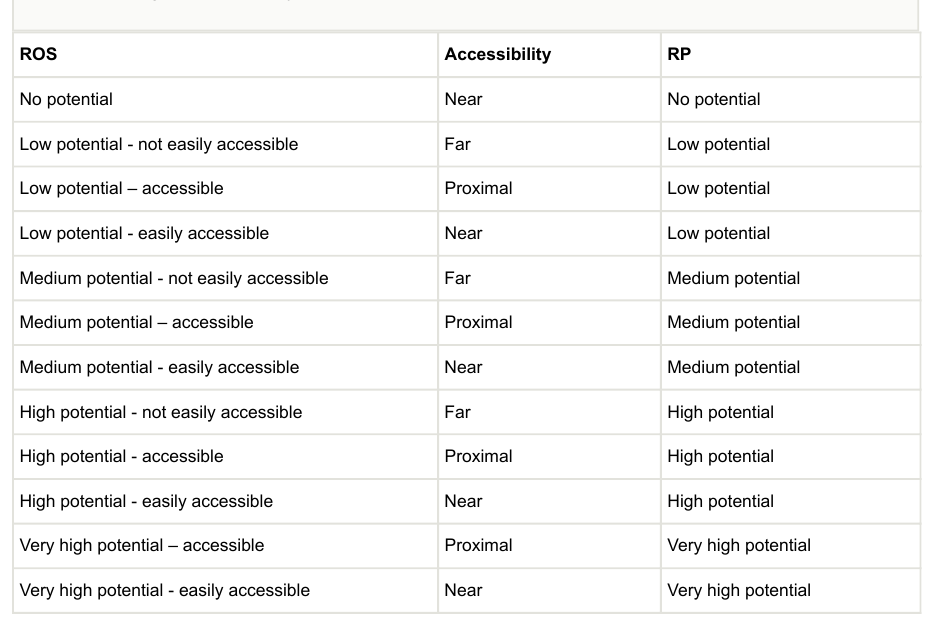
Table 7. ROS according to Accessibility and